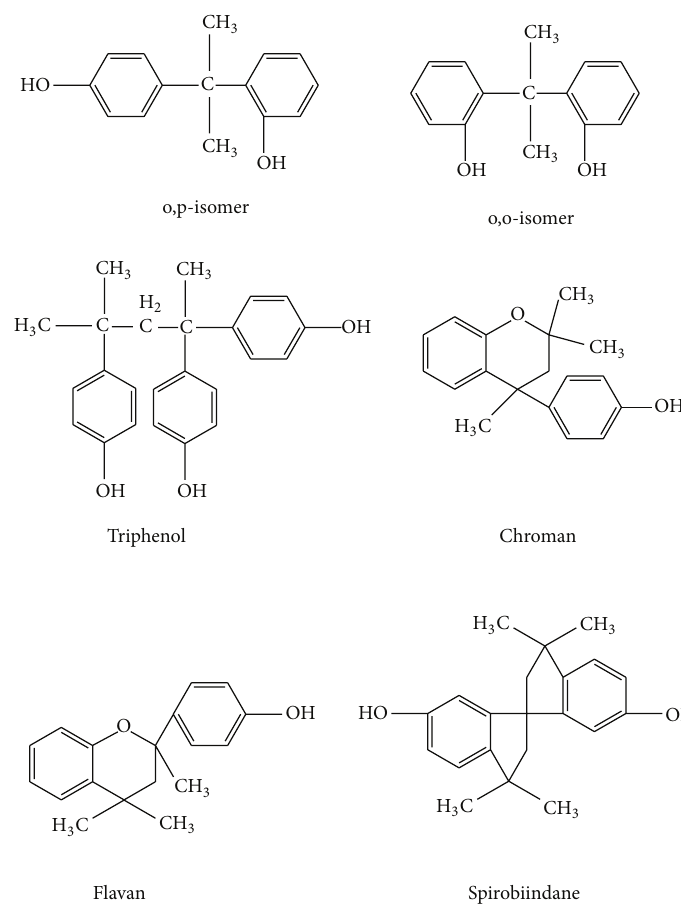
Figure 1: Formulas of the